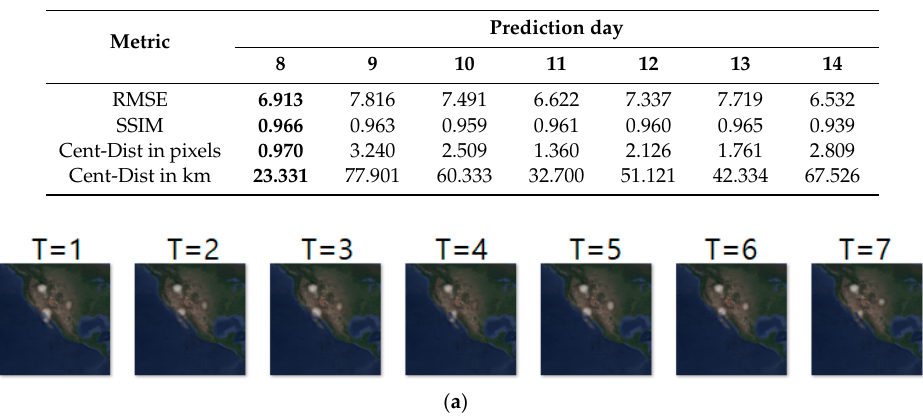
Table 11. Daily comparison of RMSE, SSIM, and centroid distance of case 1.